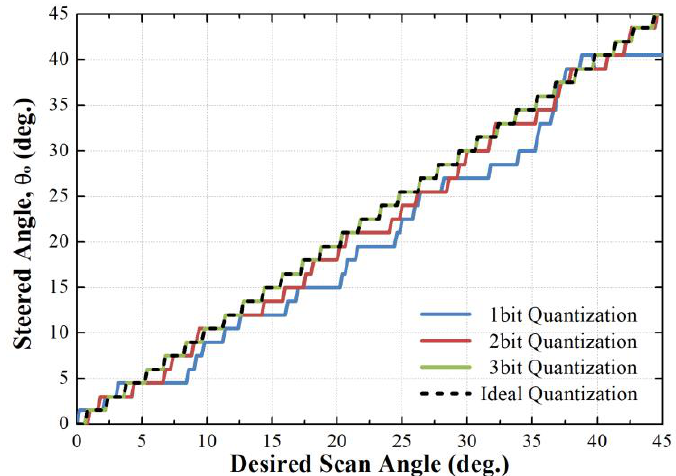
Figure 2. Analysis results of beam scanning error in variation of quantization